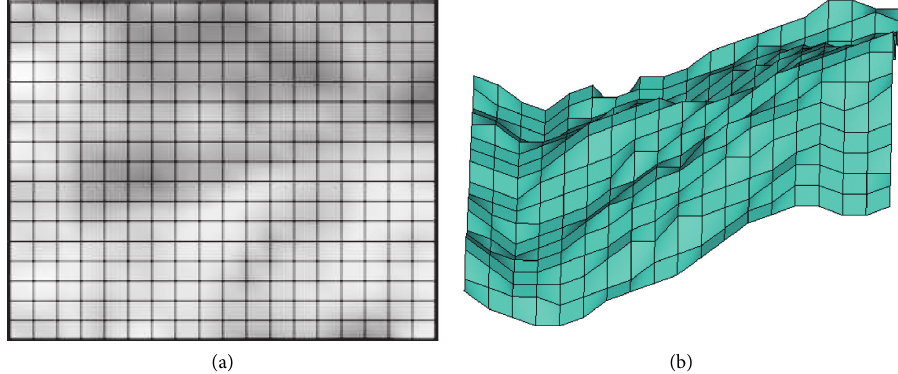
Figure 2: 3D surface model. (a) Top view grayscale image of 3D surface. (b) Three-dimensional surface stereogram.